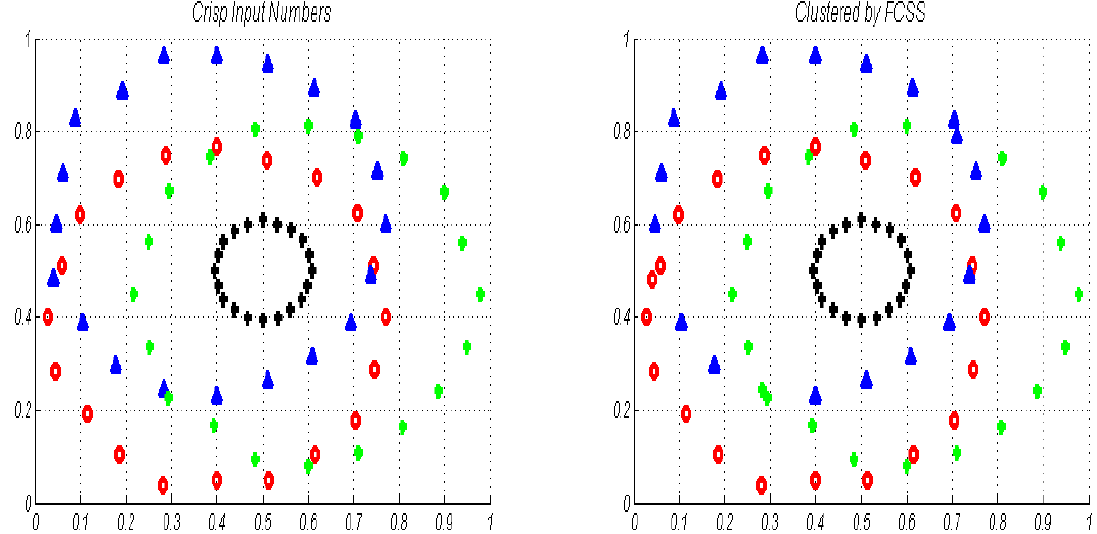
Figure 5. Proposed VFCSS clustering over input non-symmetric LR-type fuzzy numbers include four complexity interfer- ence classes red, blue, black and green with (20,20,20,20) members (second step of state 2).